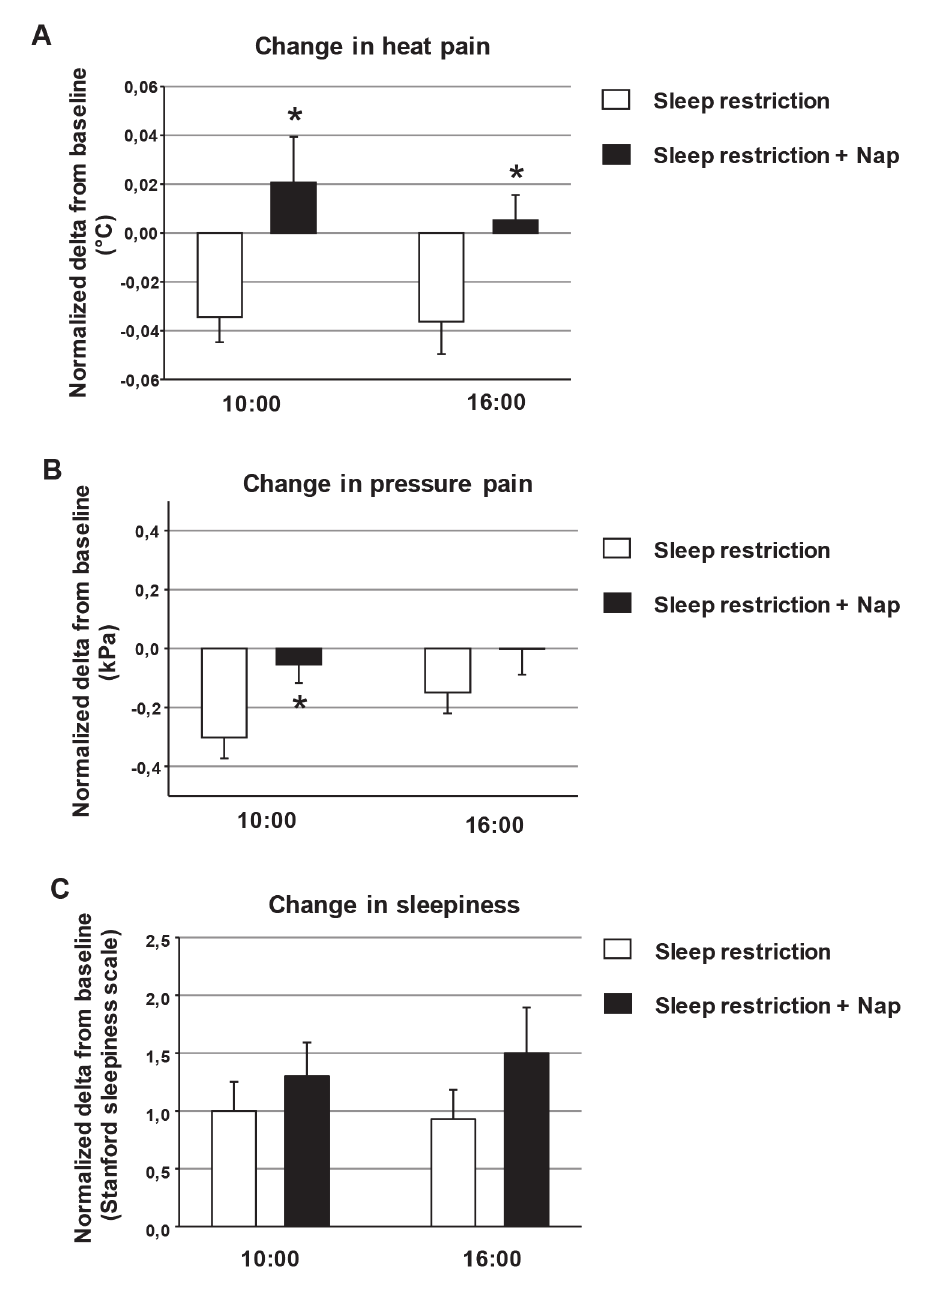
Fig 2. Changes in heat pain, pressure pain and sleepiness without or with napping after sleep restriction. We assessed the effects of napping, by comparing the different sleep restriction conditions ( “ sleep restriction ” session and “ sleep restriction + nap ” session), using normalized delta scores for each sleep restriction condition relative to the corresponding baseline. Changes are shown for heat pain (A), pressure pain (B) and sleepiness (C). Sleep restriction increased sleepiness and decreased pain tolerance, whereas napping reversed the increase in pain sensitivity but did not decrease sleepiness (due to sleep inertia). Mean ± SEM; * indicates significant differences between